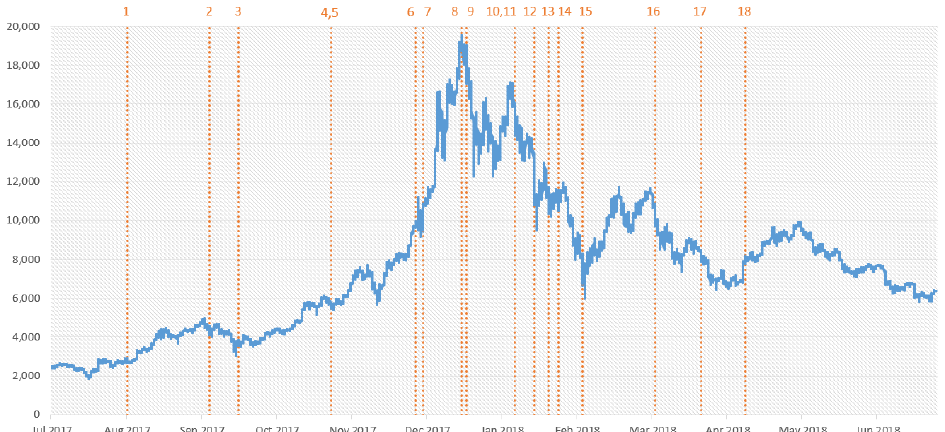
Figure 1. Bitstamp price (USD). Note : The figure shows the Bitstamp price series (USD) related to the sample period 1 July 2017–30 June 2018. Dotted lines indicate the dates at which the main events related to cryptocurrencies described in Table 1 occurred.